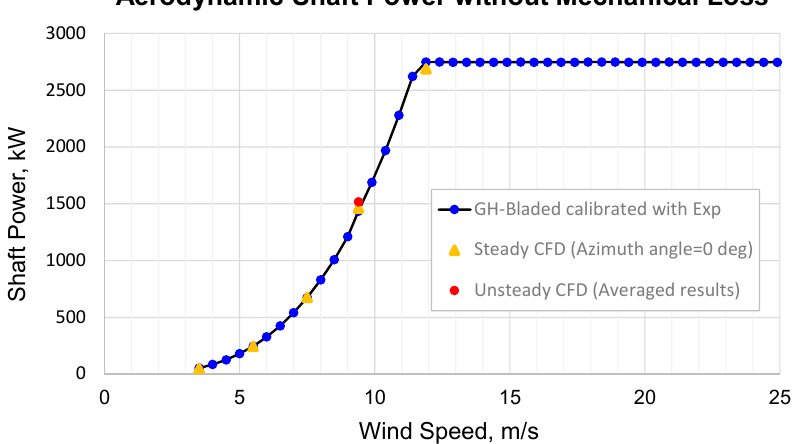
Figure 4. Numerical verification of aerodynamic performance.